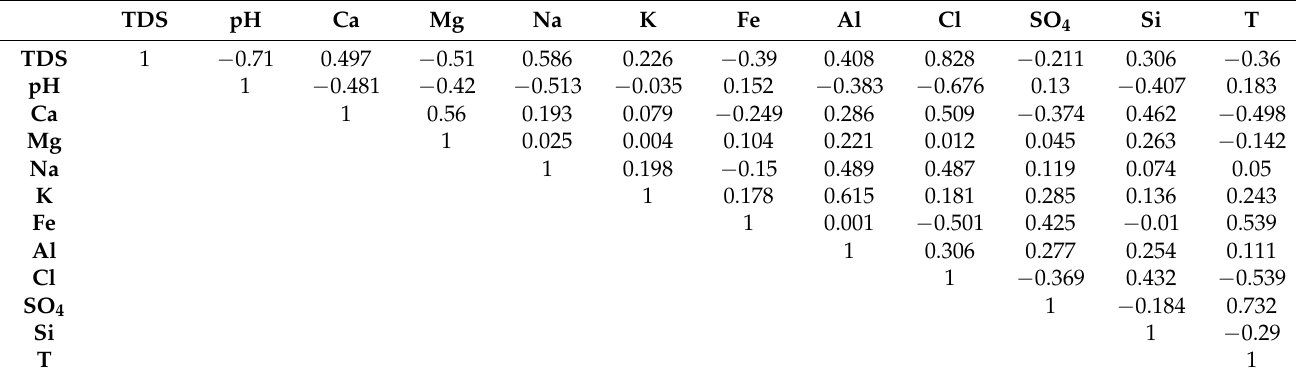
Table 4. Correlation analysis of the main ions of TYK thermal fluid in period 4.